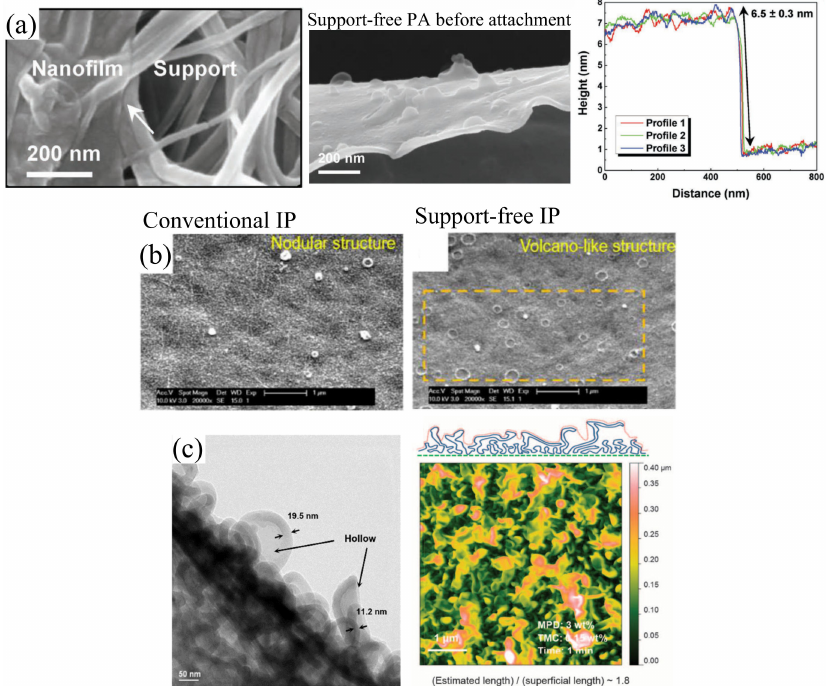
Figure 5. ( a ) SEM image and AFM profile of free-standing nanofilm formed without substrate interference [79], ( b ) SEM surface morphology of TFC-NF membranes formed via conventional and support-free IP [77] and ( c ) cross-sectional TEM and AFM images of crumpled PA film formed via support-free IP